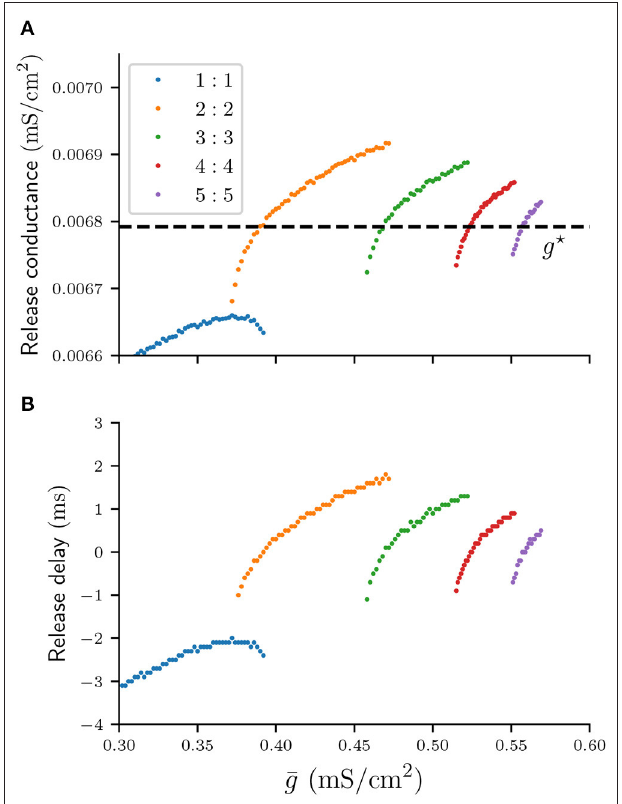
FIGURE 4 | Numerically computed values of the release conductance (A) and release delay (B) for various n : n solutions and values ¯ g . The dashed line indicates the analytical approximation of the release conductance by g ⋆ .